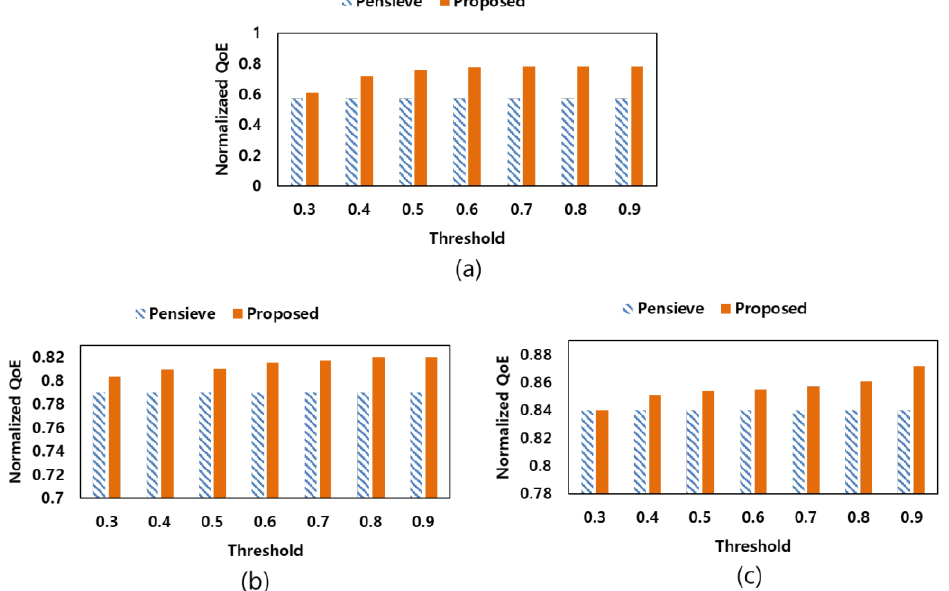
Figure 9. Change of the normalized QoE according to change of threshold value, ( a ) Dataset #2, ( b ) Dataset #4, ( c ) Dataset #7.